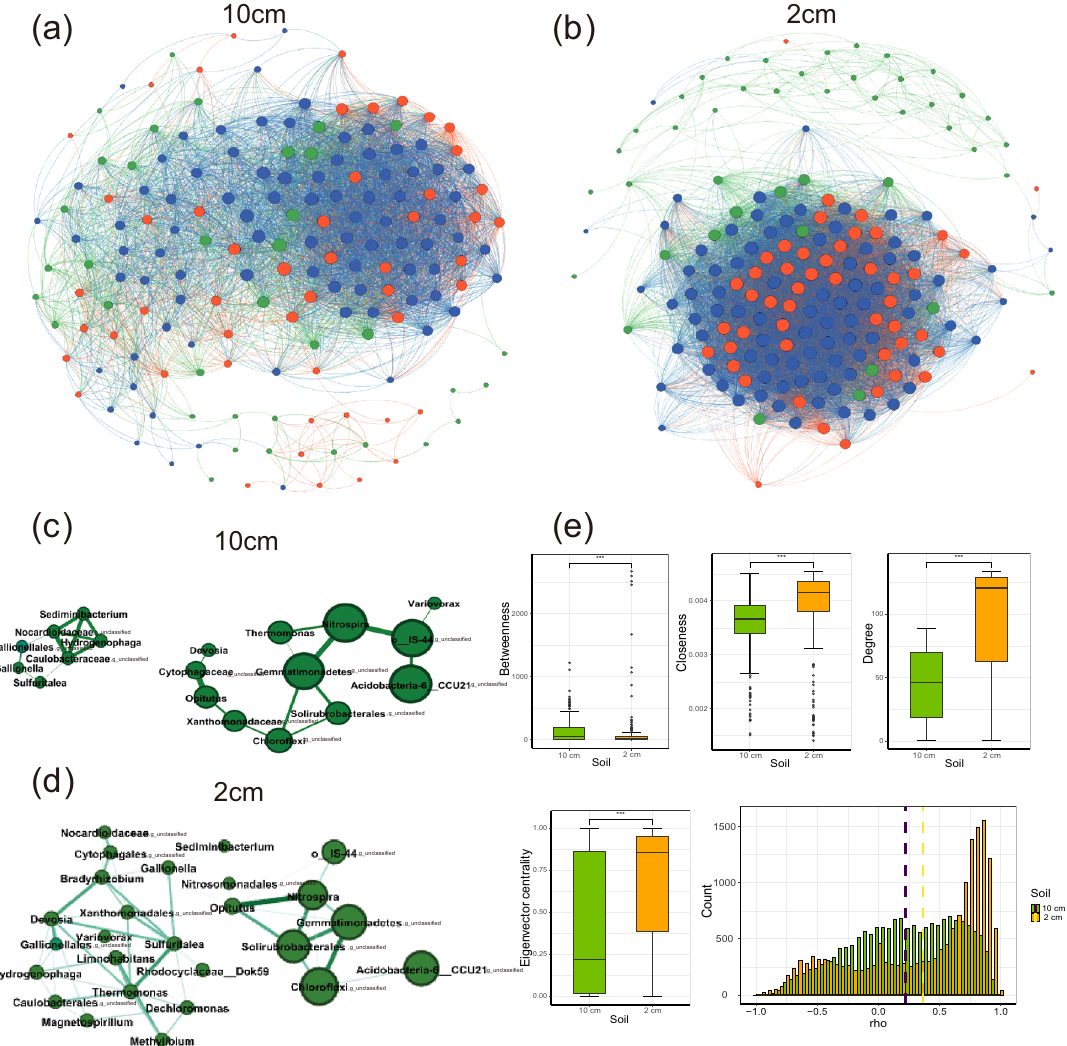
Fig. 8 Microbial co-occurrence networks and its characteristics. Co-occurrence network analysis of the microbial communities (at genus level) of soil at 2 cm ( a ) and 10cm ( b ) distance from metal coupons. Taxa with the positive response to metal corrosion in soil 2 cm ( c ) and 10 cm ( d ) distance from metal coupons. Network characteristics of microbial co-occurrence network (from the left to right, n = 16 and 22) ( e ). The node size represented the node degree and the colors of nodes indicated the microbial response to metal corrosion in the network: green nodes, microorganisms with signi fi cantly higher relative abundance at 2 cm (positive response to metal); orange nodes, microorganisms of which relative abundance decreased signi fi cantly at 2 cm (negative response to metal); blue nodes, microorganisms of which relative abundance had no signi fi cant difference between 2 and 10 cm. Note, error bars represented SD; *** p -value <